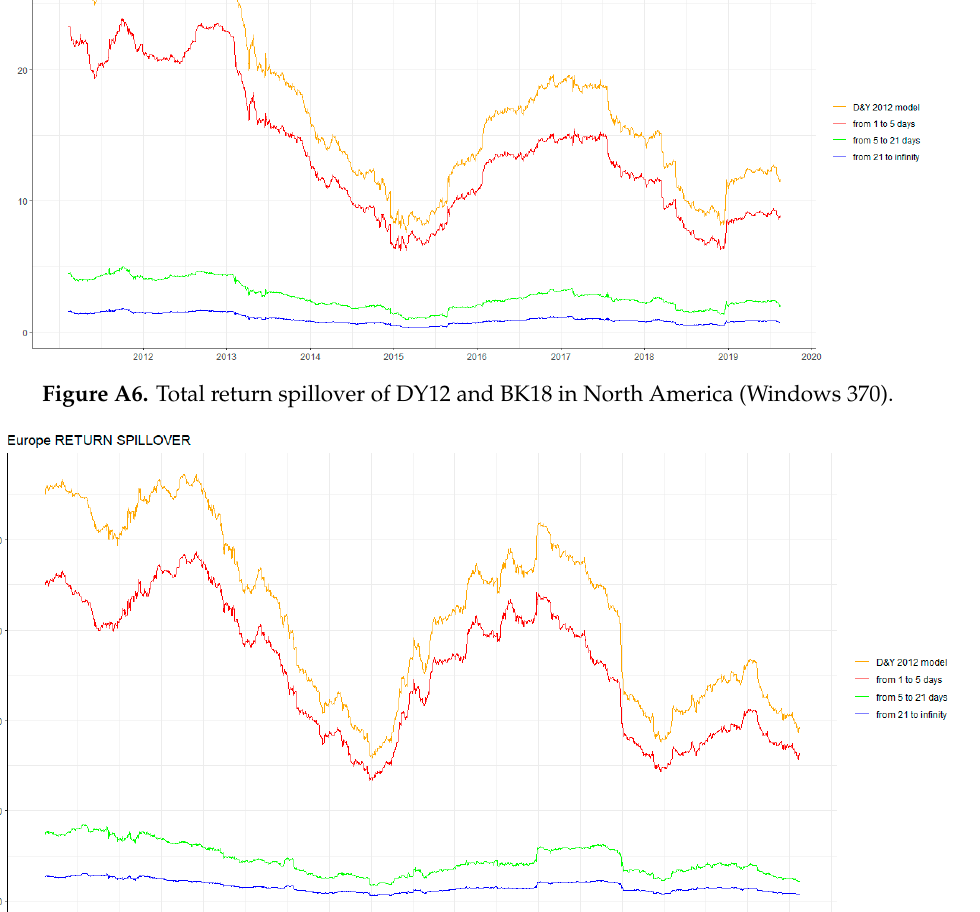
Figure A8. Total return spillover of DY12 and BK18 in Europe (Windows 370).